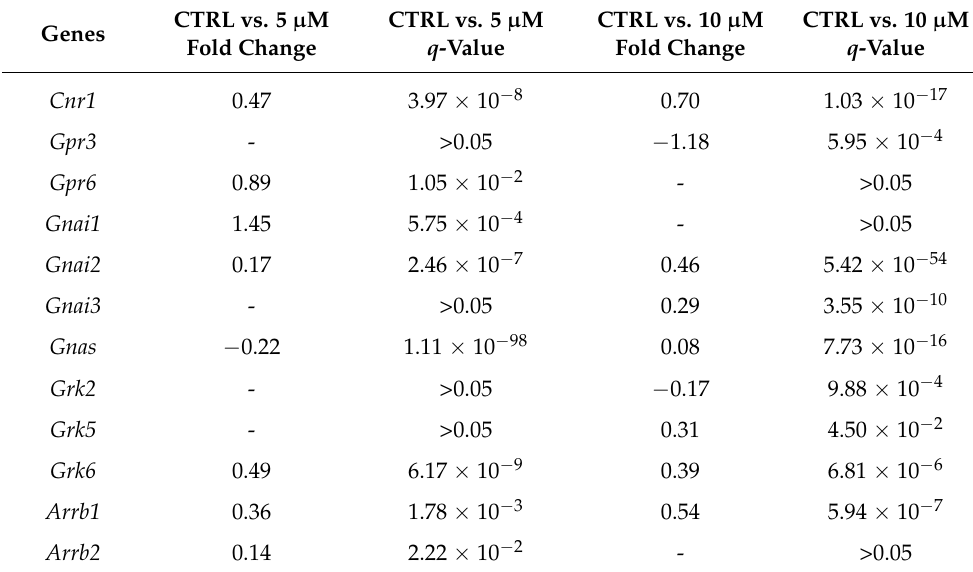
Table 1. DEGs associated with the G protein-coupled receptors and CBD. CTRL vs. 5 µ M Genes